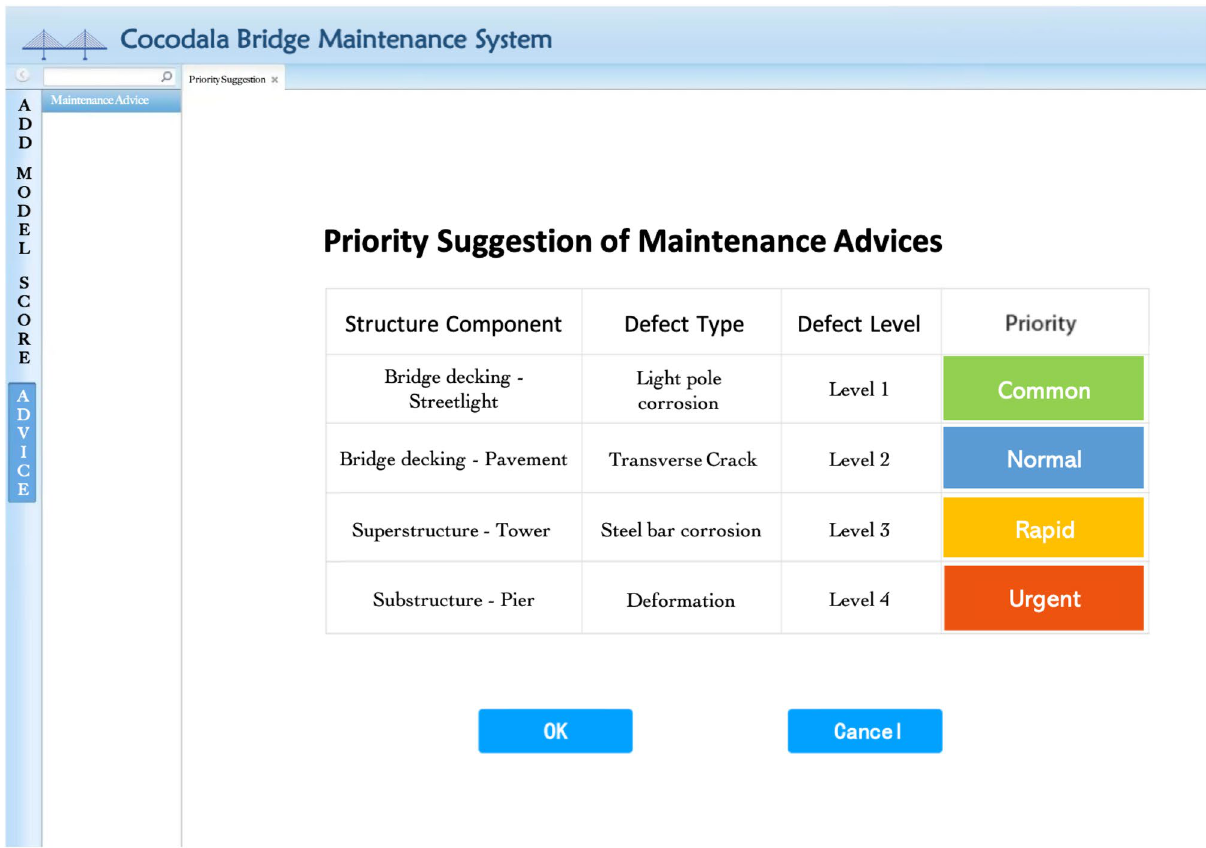
Figure 17. Priority suggestions of bridge maintenance are advised with